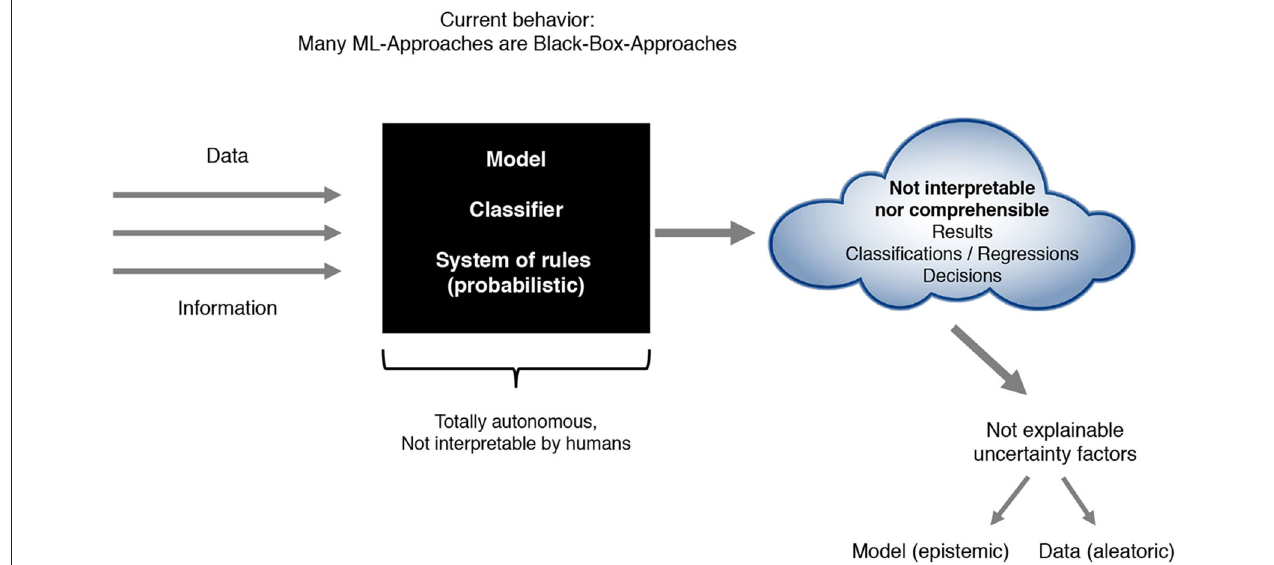
FIGURE 1 | Present ML-approaches as black-box